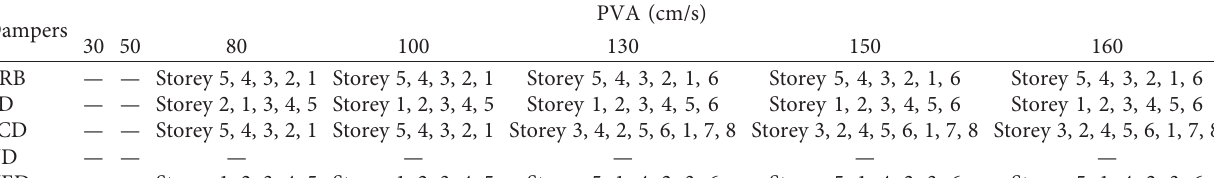
Table 8: Storeys where the five dampers fail under the ANE with different PVAs.